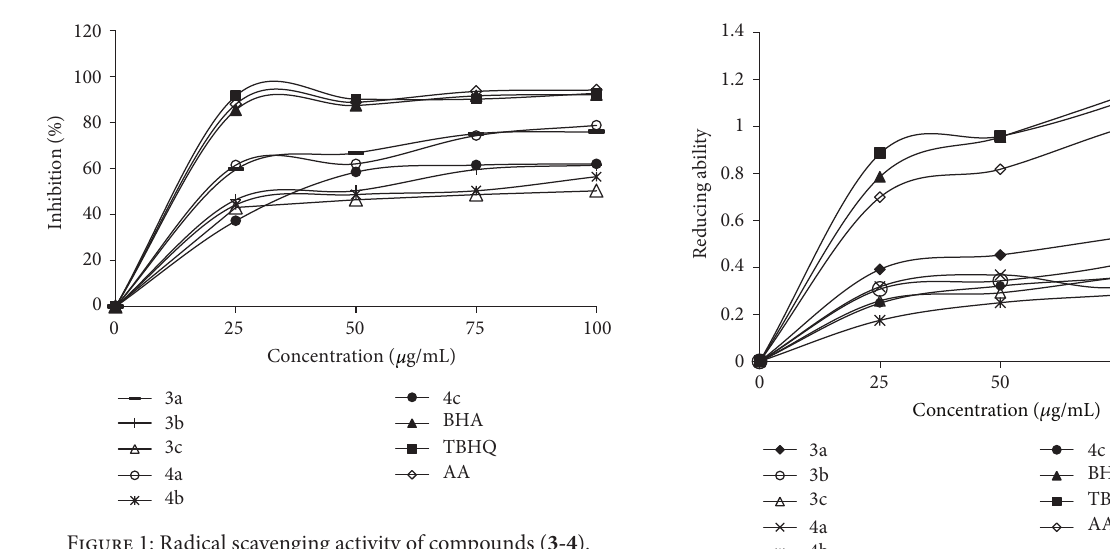
F 1: Radical scavenging activity of compounds ( 3-4 ).